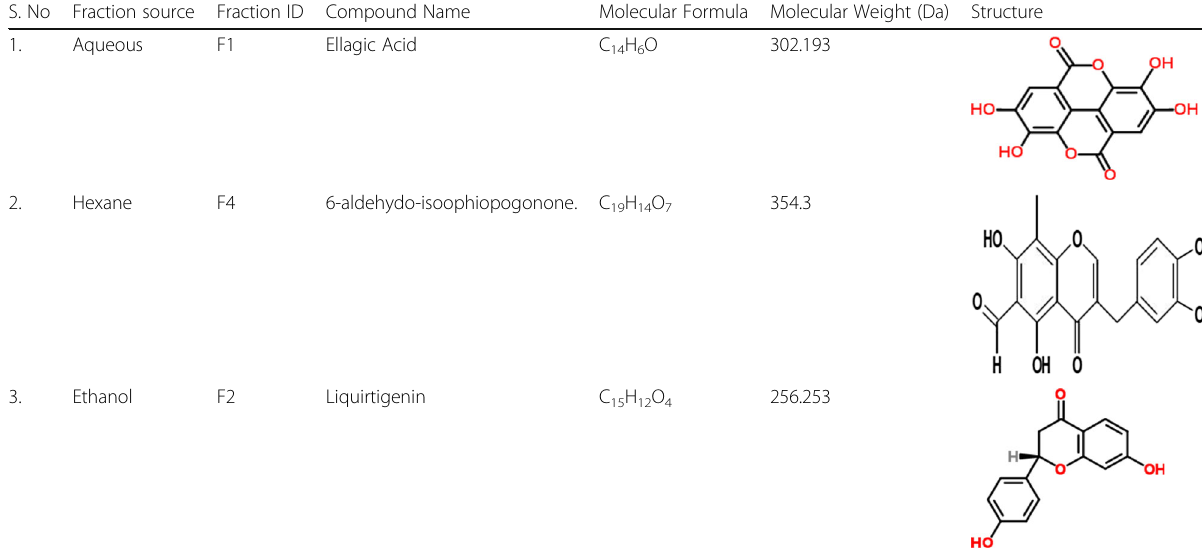
Table 2 Profile of bioactive compounds of Glycyrrhiza glabra identified by LC MS/MS analysis